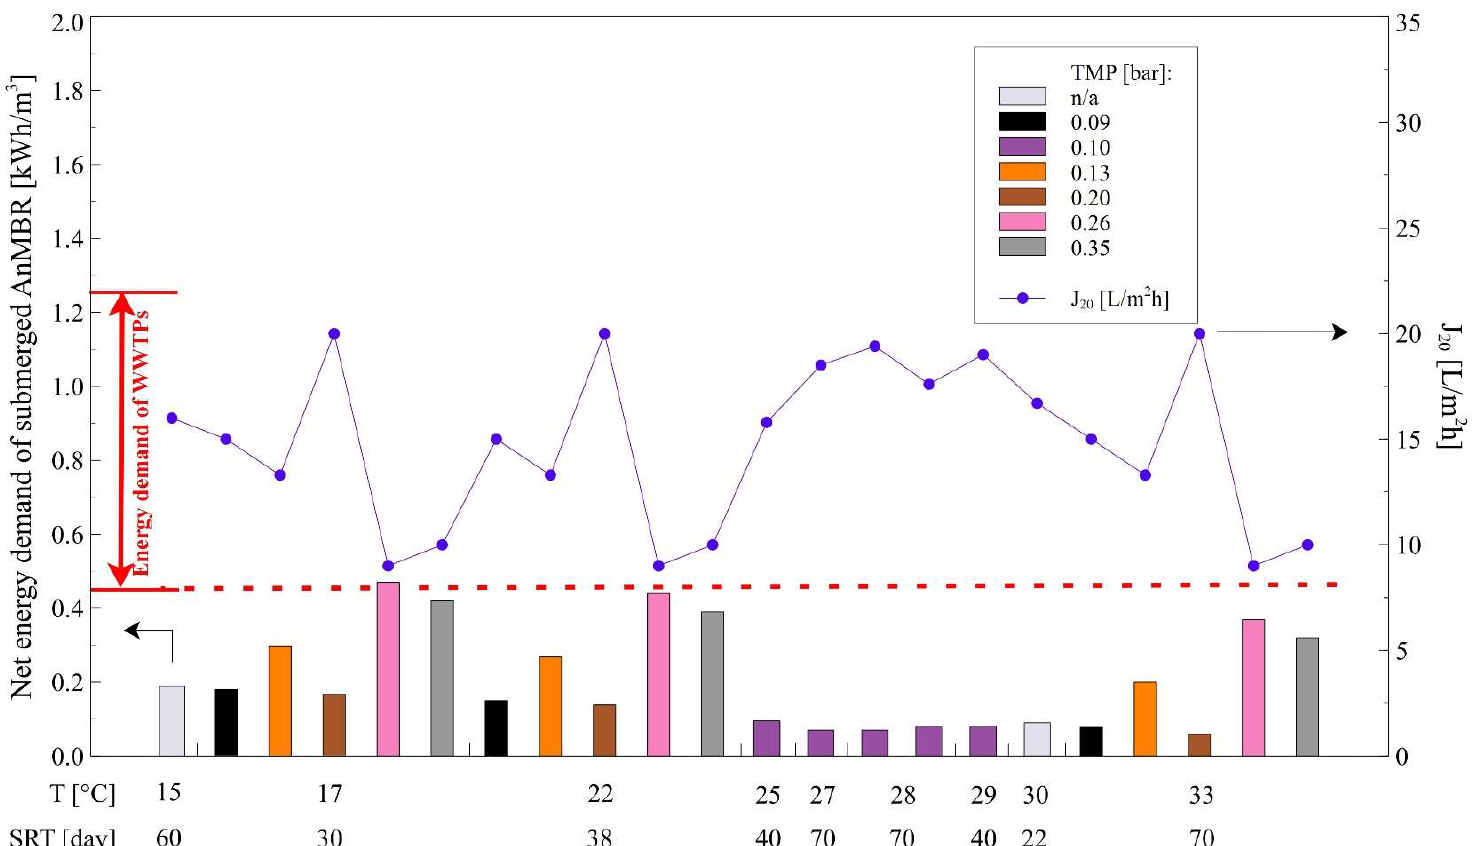
Figure 6. Net energy demand of submerged AnMBRs is used for the treatment of sulphate-rich municipal wastewaters. Assumption: energy recovery from biogas methane and methane dissolved in the effluent. Based on [47,190,191]. n/a—no information; T—temperature; SRT—solid retention time; TMP—transmembrane pressure; J 20 —20 °C-standardized critical fluxes.